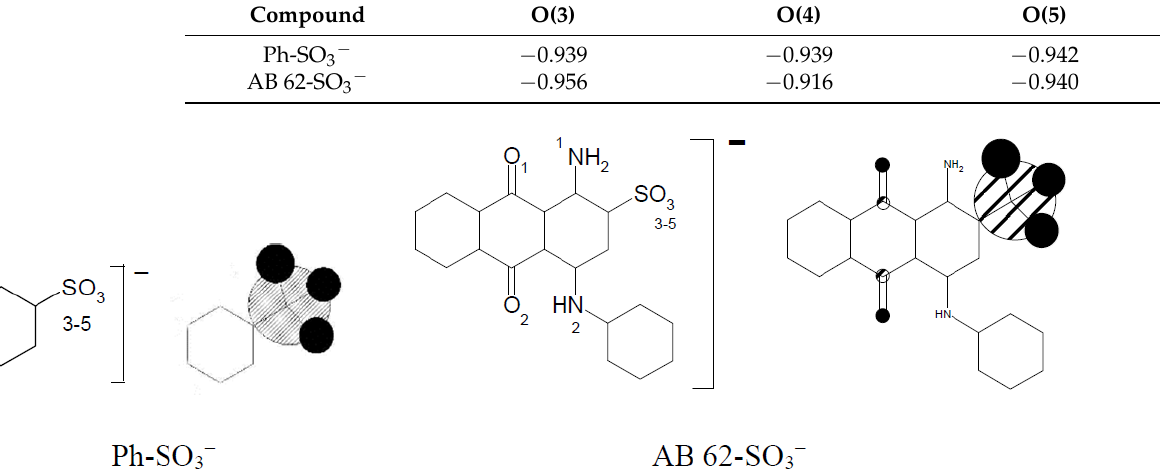
Table 9. The summary data electron density for analysed oxygen atoms of [Cell-O(6)-IME] + ∙PhSO 3 − . Compound